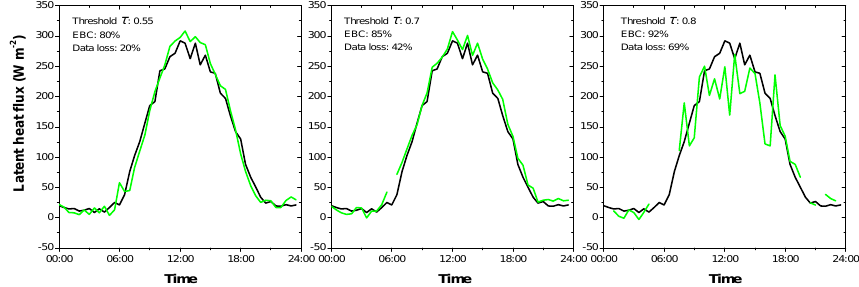
Figure 4. Effect of the energy balance ratio threshold τ on the pattern of the mean diurnal cycle of measured latent heat fluxes in May 2011. Only flux data with an energy balance ratio (EBR) τ <EBR <2 − τ were used to compute the mean diurnal course (green line). The black line shows the mean diurnal course for τ = 0